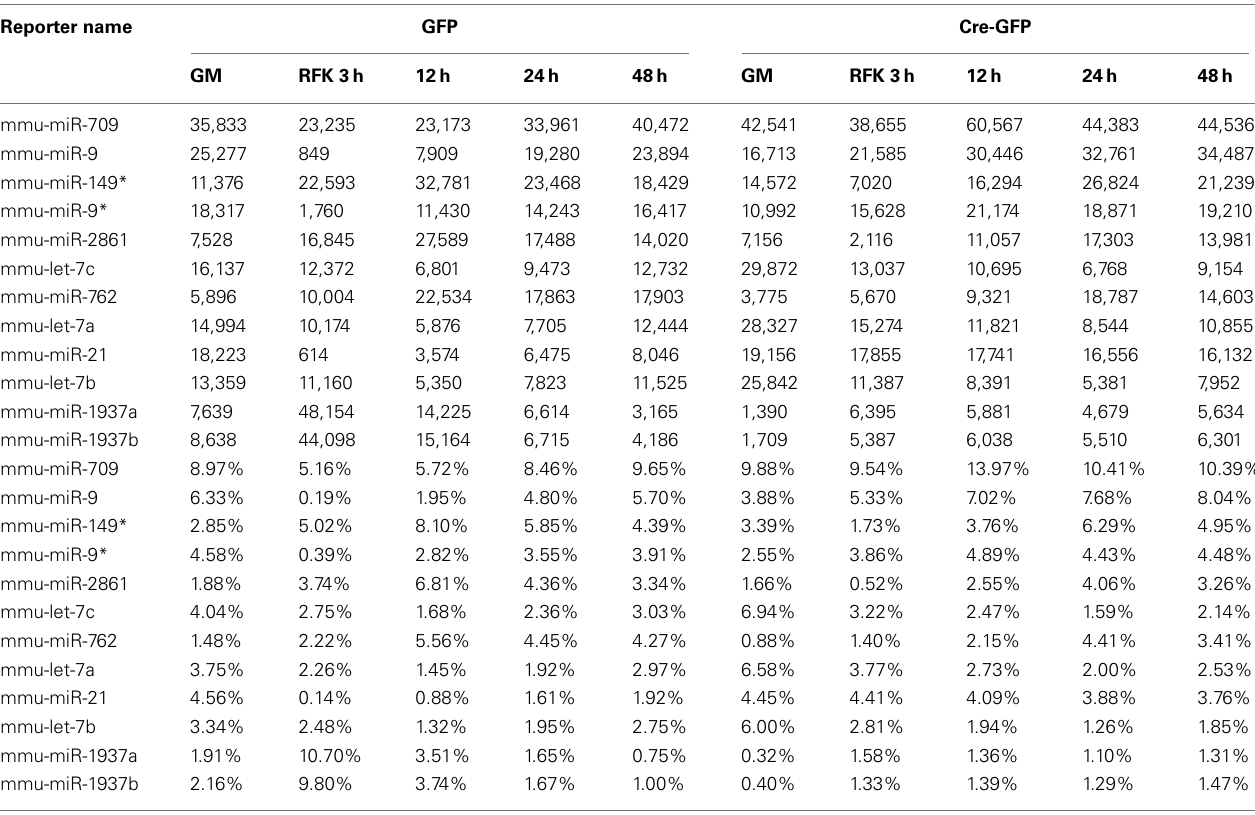
TableA5 | Highly expressed miRNA